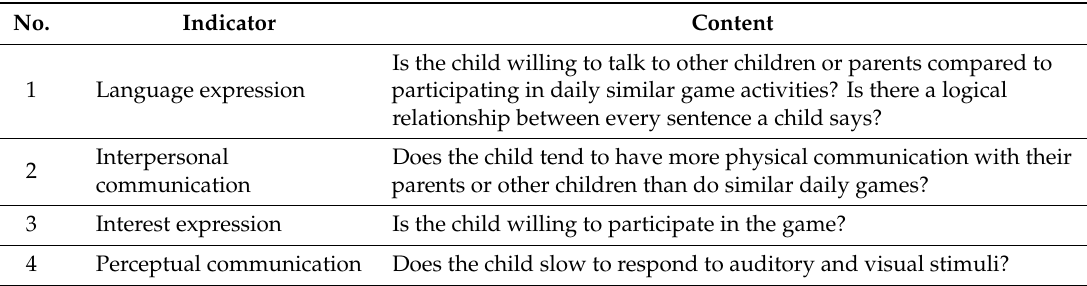
Table 1. Evaluation indicator and content.